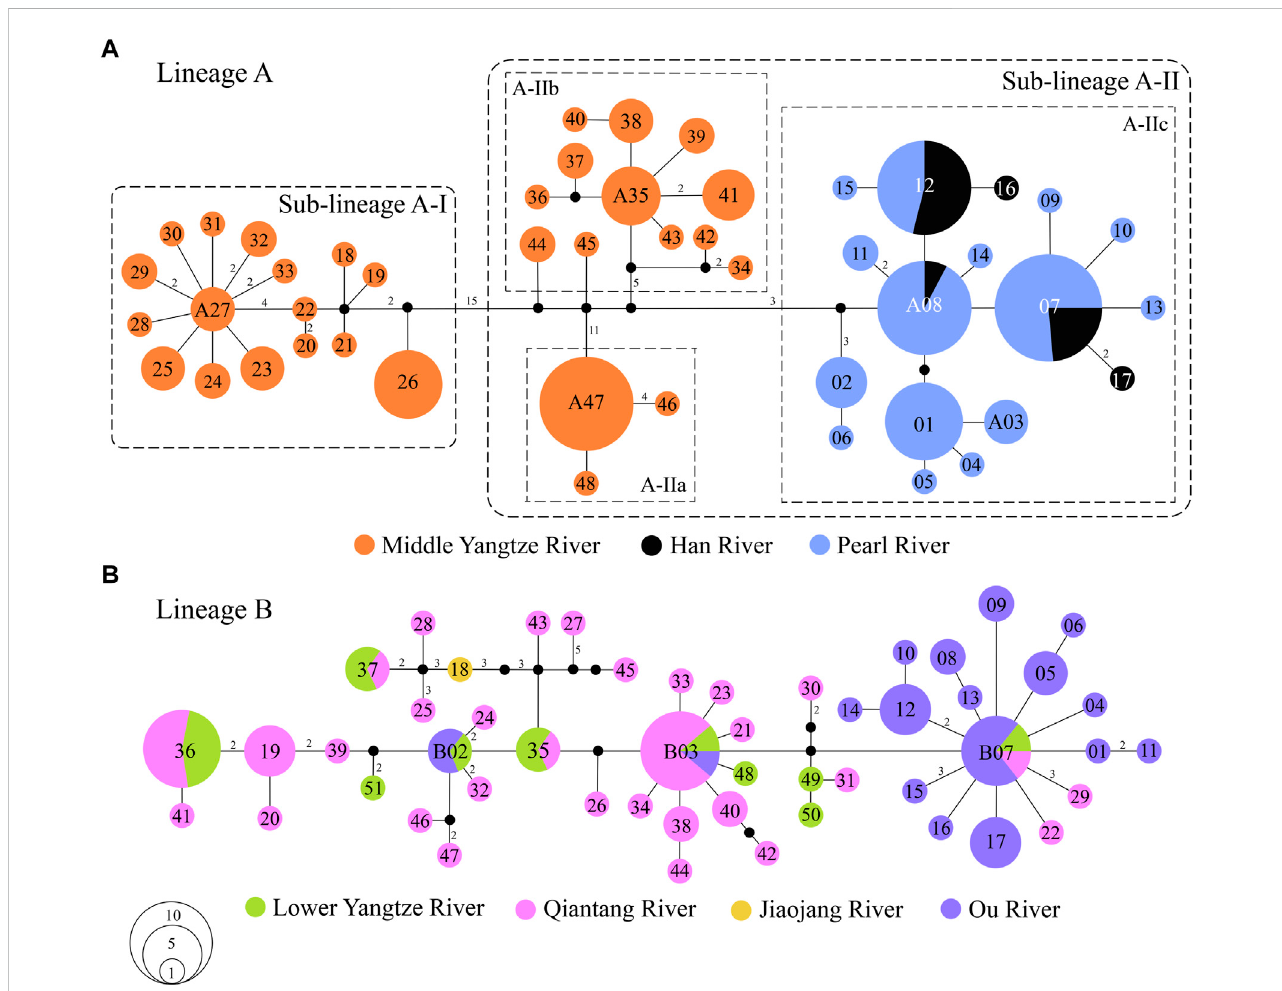
FIGURE 3 Median-joining networksof S. parvus : (A) LineageA; and (B) LineageB. The numbersin thecircle represent thecodes ofhaplotypes intheLineageA and B.Themutationstepsareshownasthenumbersalongthebranches,exceptforonemutationstep,andmissing(unsampled)haplotypeispresentedbyablack dot. The area of each circle is proportional to the number of individuals for each haplotype.